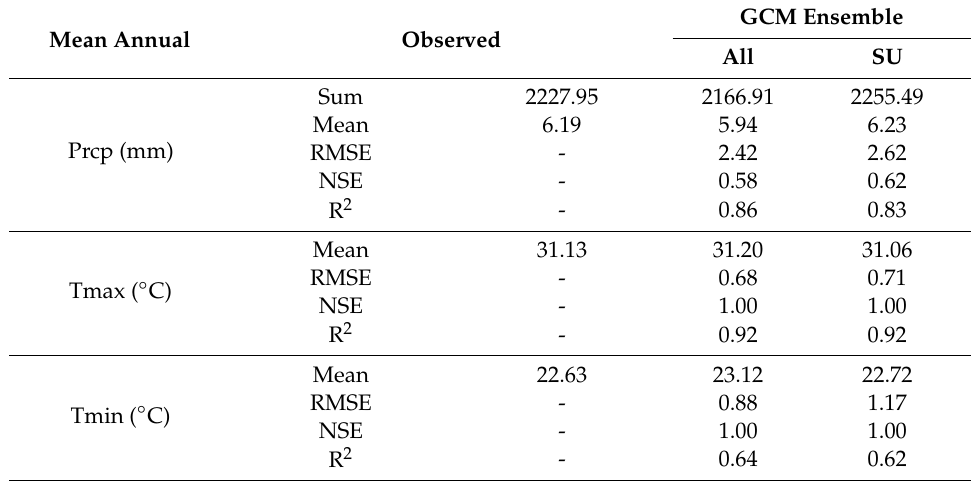
Table 3. Performance assessment of the GCM ensemble at the grid located in Port Harcourt.